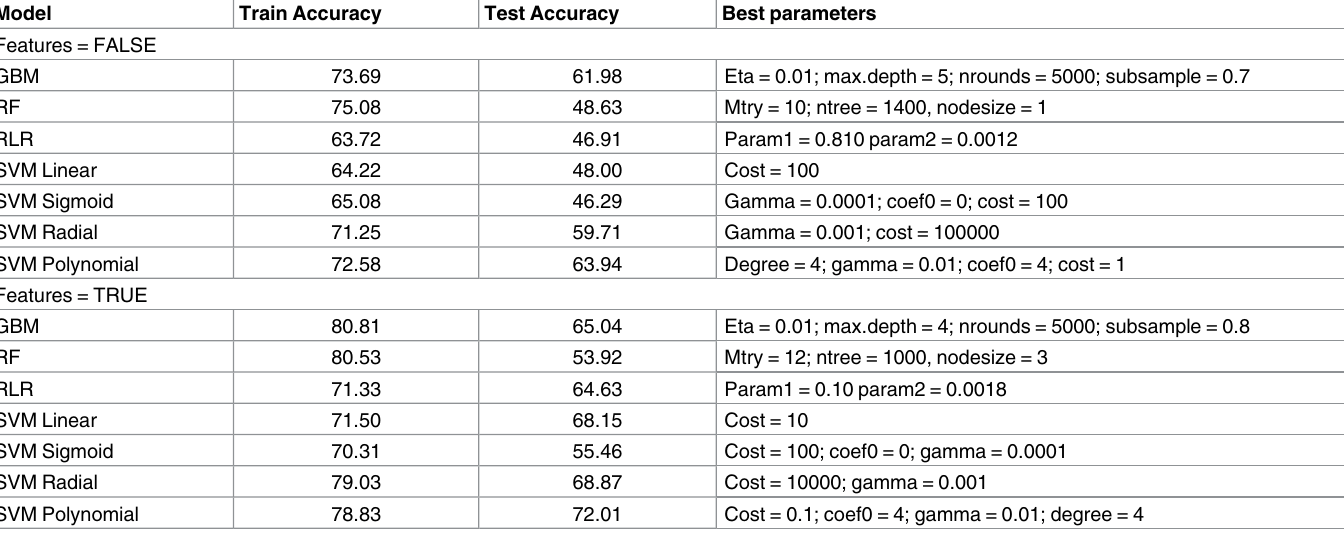
Table 3. Average training (ten animals) and testing (two unseen animals) accuracyof machine learning models run with and without feature statis- tics and the best parameters used for testing. Model